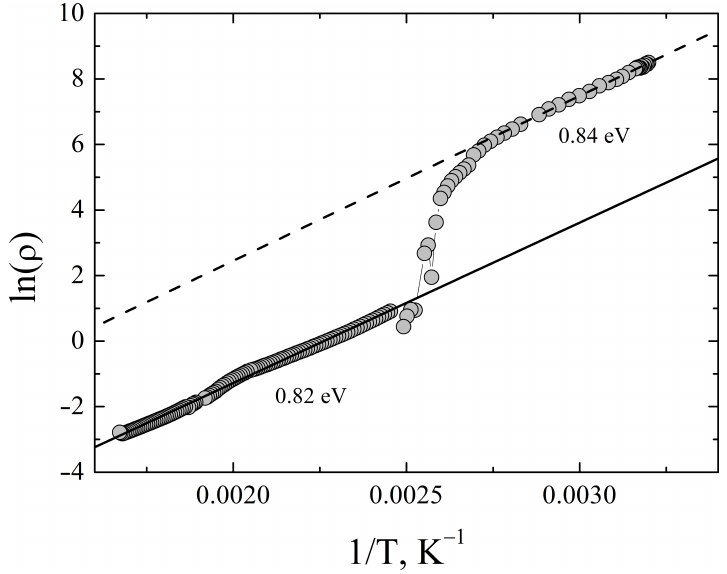
Figure 7. The dependence of the ln ρ ( T ) vs 1/ T for Ag 3 CuS 2